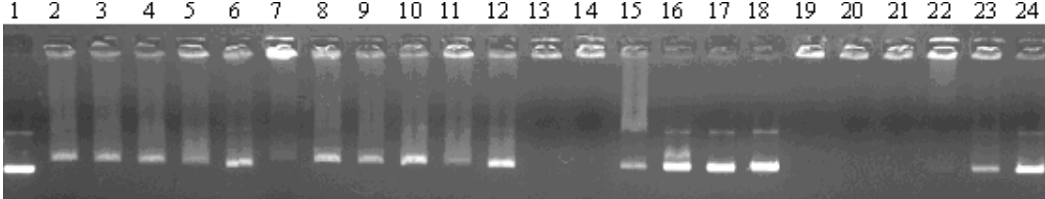
Figure 1. Effect of different ligands and complexes on the interaction with pUC19 DNA (7 m g/ml) in a Tris-HCl buffer (100 mM, pH 7.4) at 37 ºC for 0.5 h. Agarose gel electrophoresis diagram: lane 1, DNA control ; lanes 2-6, ligand: [ 6a ] = 1.40, 0.70, 0.35, 0.18, 0.09 mM; lanes 7-12 ligand: [ 6b ] = 1.40, 0.70, 0.35, 0.18, 0.09, 0.05 mM; lanes 13-18 complex: [ 1a ] = 0.144, 0.072, 0.036, 0.018,